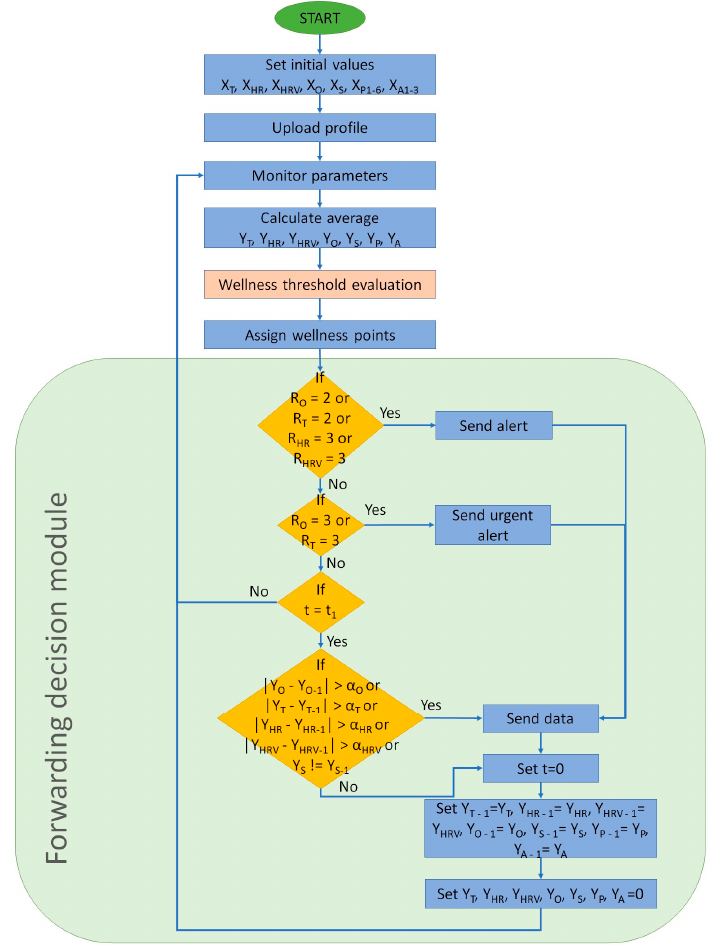
Figure 3. Algorithm of the performance of the system.